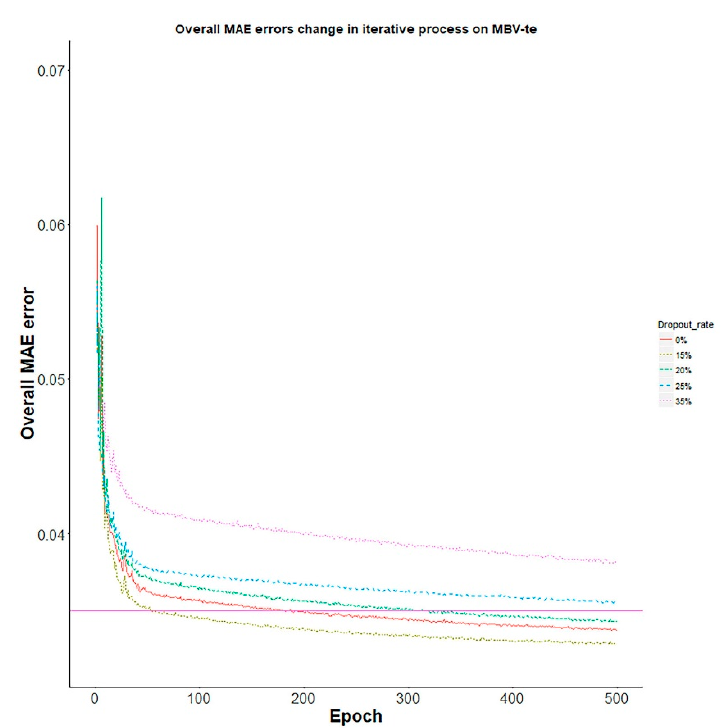
Figure 10. The overall MAE decreasing curves of D-GPM-15%-7000 × 5 for the MBV-te, with different dropout rates. The x-axis is the training epoch and the y-axis is the overall MAE error. The overall MAE error of SVM is also covered for comparison.